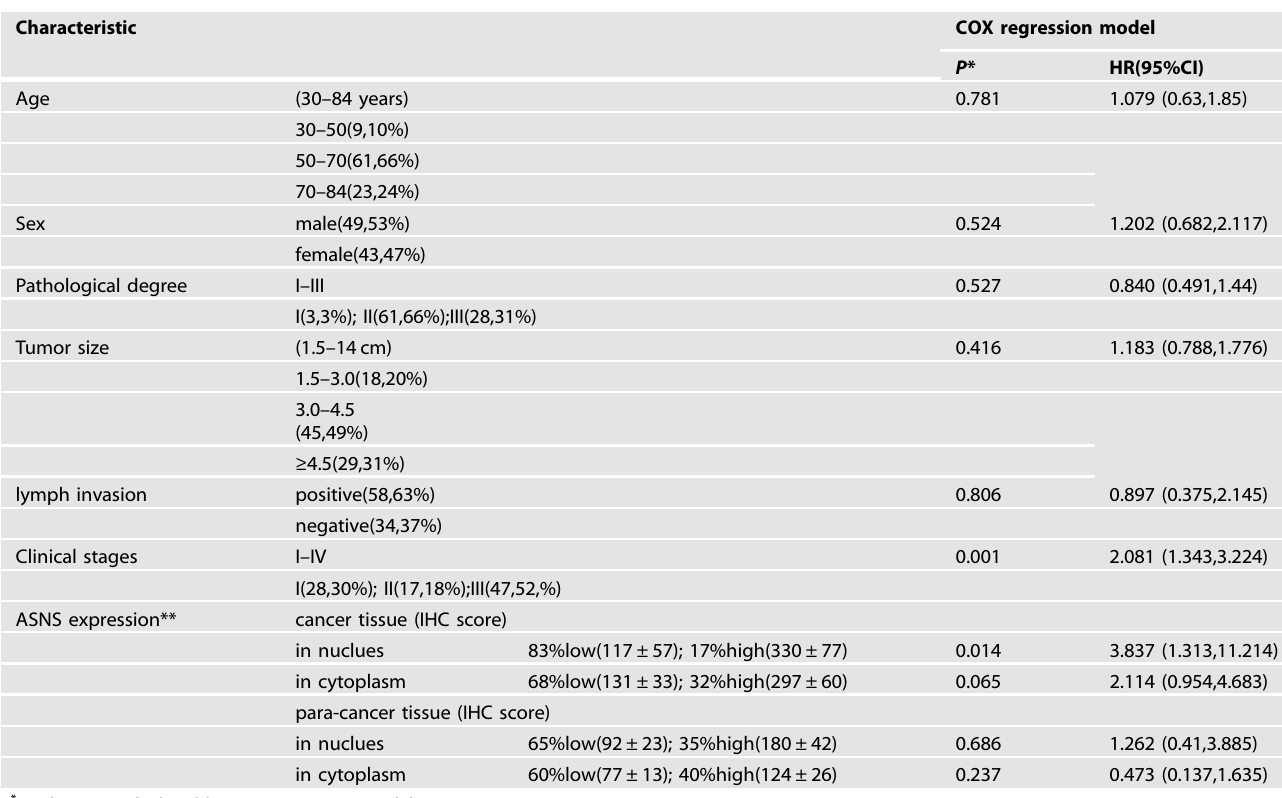
Table 1. The clinical characteristic and ASNS level in non-small cell lung-cancer patients ( N = 92).